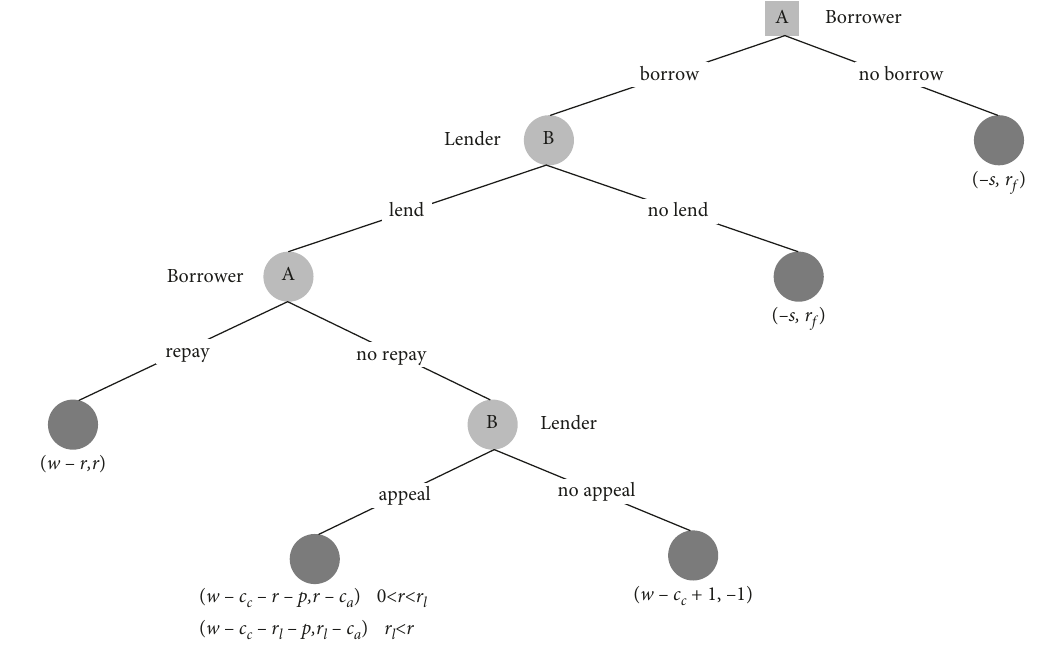
Figure 1: Game relationship